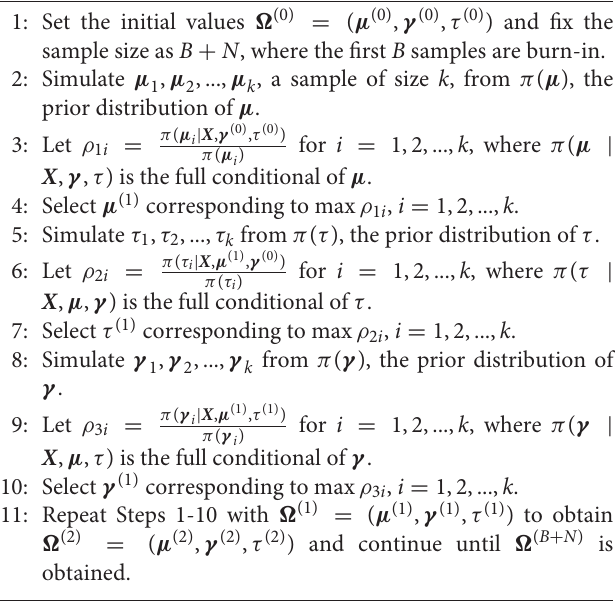
Algorithm 1 : Steps to generate samples from the posteriors by using priors and full